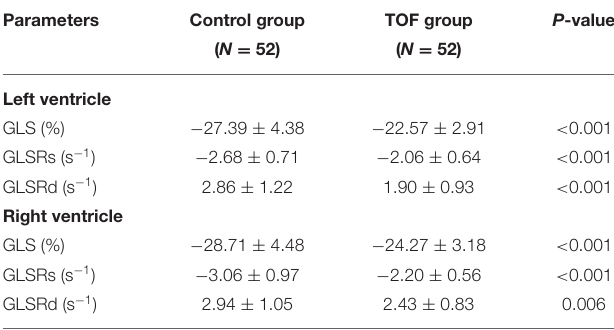
TABLE 2 | Myocardial strain by two-dimensional speckle tracking of the left and right ventricles in fetuses with TOF and controls. Parameters Control group TOF